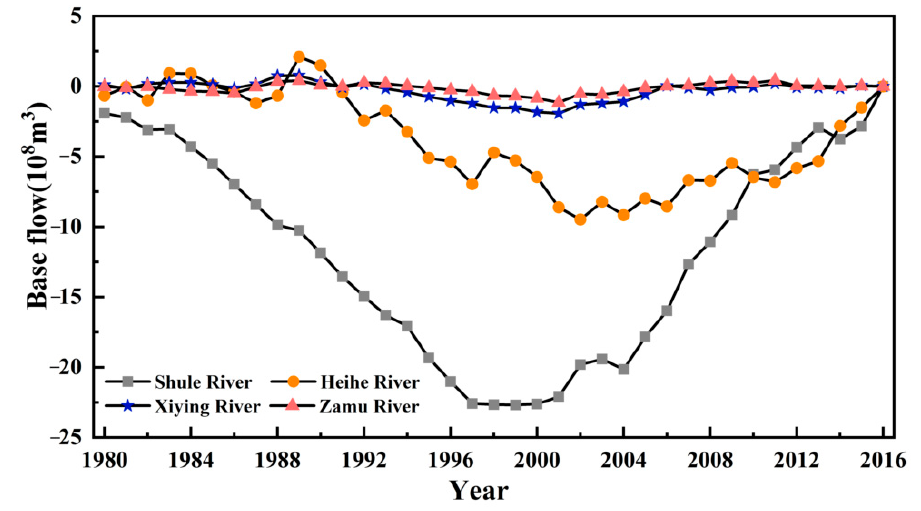
Figure 6. The cumulative anomaly curve of the base flow change in the Hexi inland rivers basin.